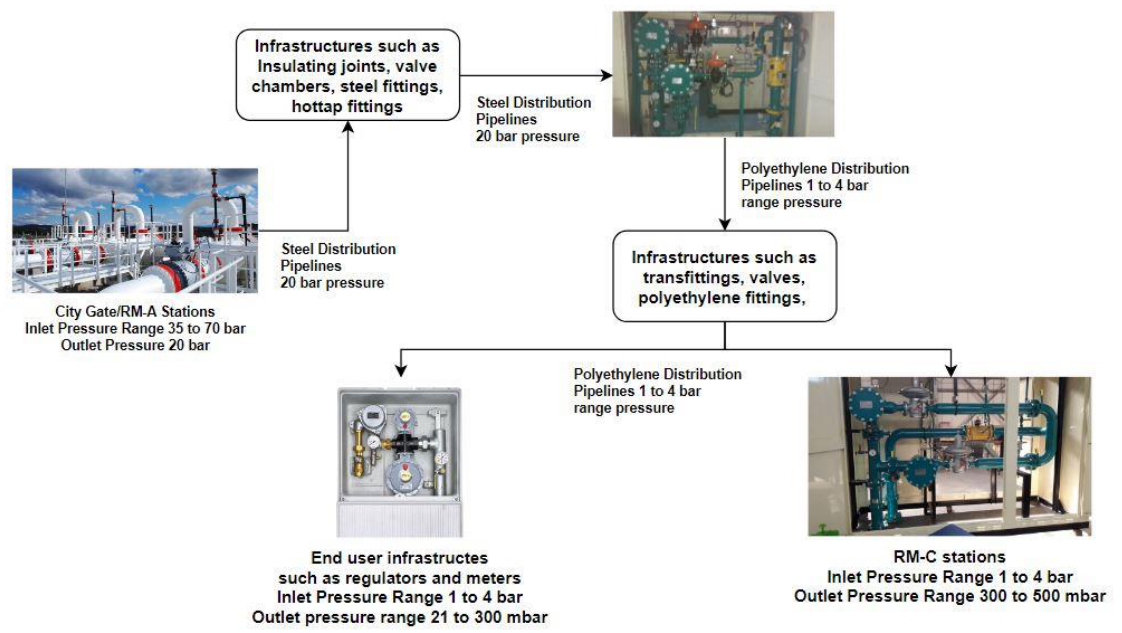
Figure 1. Istanbul natural gas distribution network.